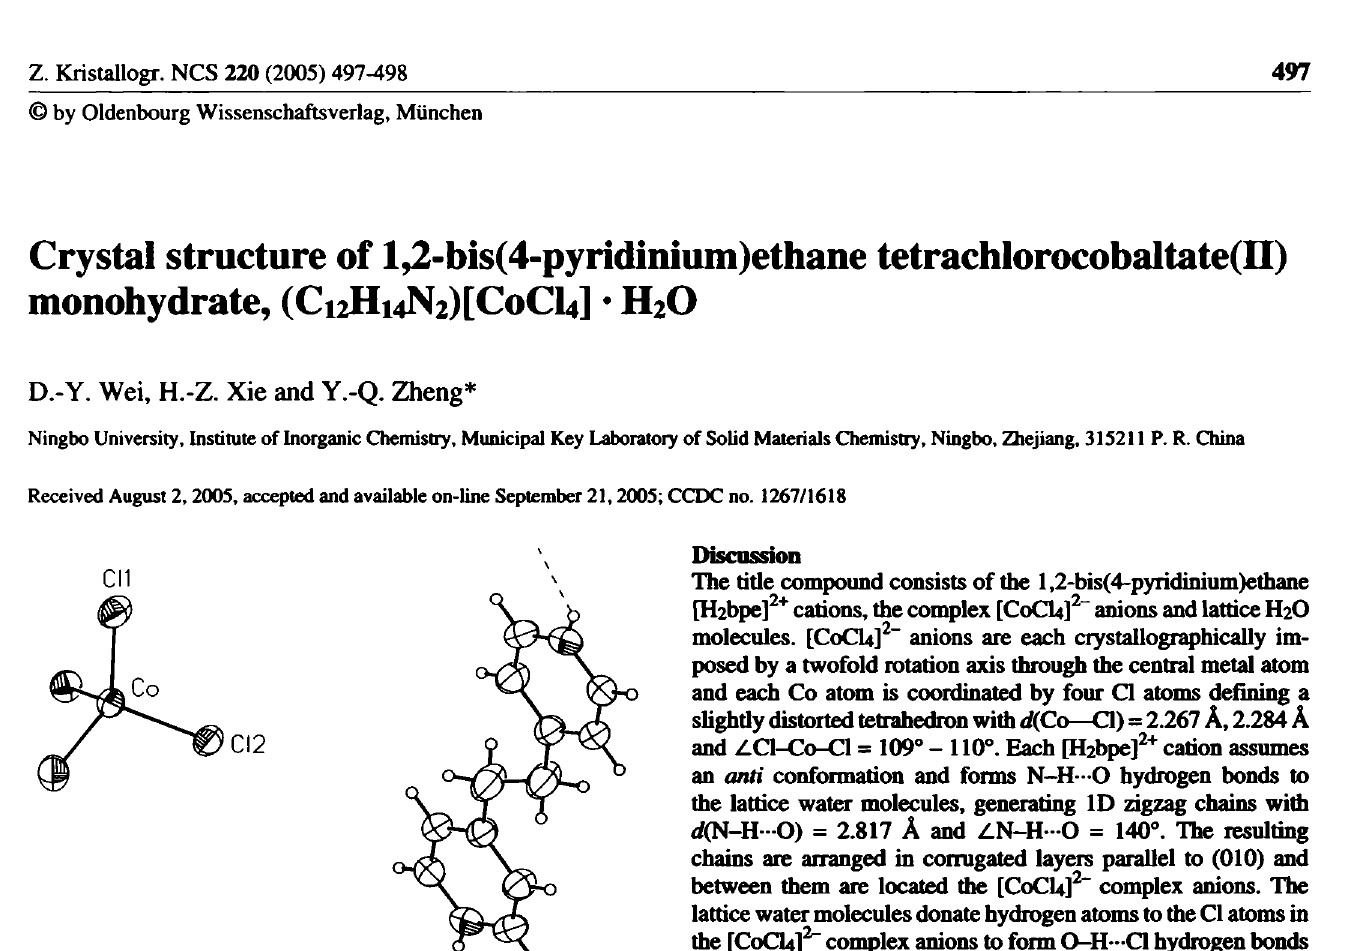
Table 1. Data collection and handling.